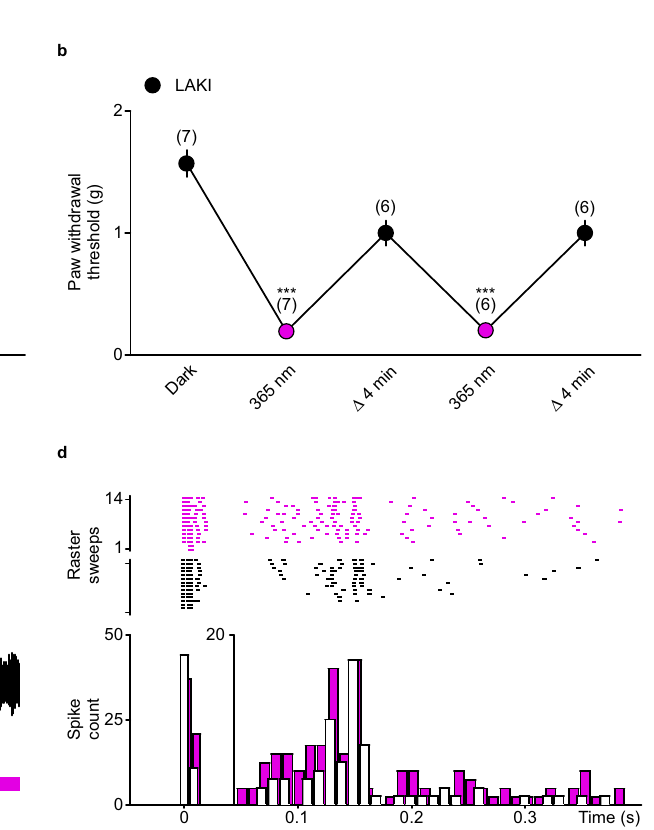
Fig. 4 | LAKI controls mechanical allodynia in mice by sensitization of noci- ceptor excitability. a Bar graph summarizing the paw withdrawal threshold of mice injected either with saline solution or with LAKI (100 µ M, 15 µ L) in the dark or after 20s illumination at 365nm (magenta). n was obtained from seven indepen- dentexperiments.Statisticalsigni fi cancewasdeterminedbyamixed-effectsmodel withrepeatedmeasuresfollowedbyHolm – Sidak ’ spost-test(*** p <0.001). b Graph summarizing the average of the paw withdrawal threshold of mice injected with LAKI (100 µ M, 15 µ L) relative to mice injected with saline solution, in the dark or after 20s illumination at 365nm (magenta). n was obtained from seven